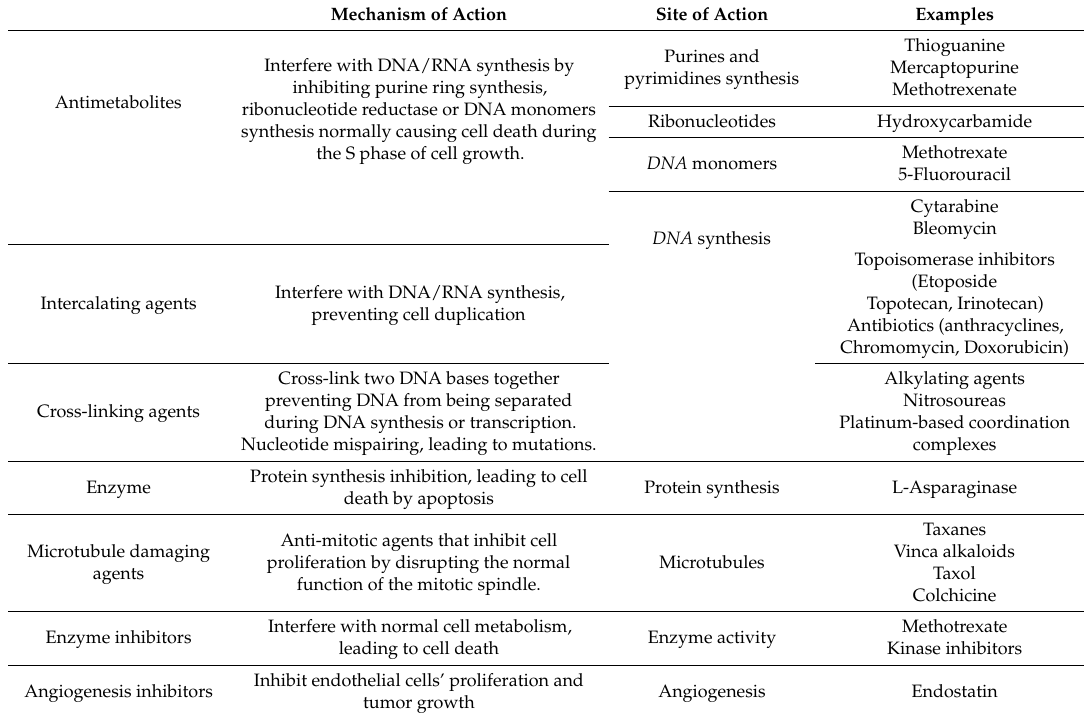
Table 1. Chemotherapeutic agents: classification and mechanisms of